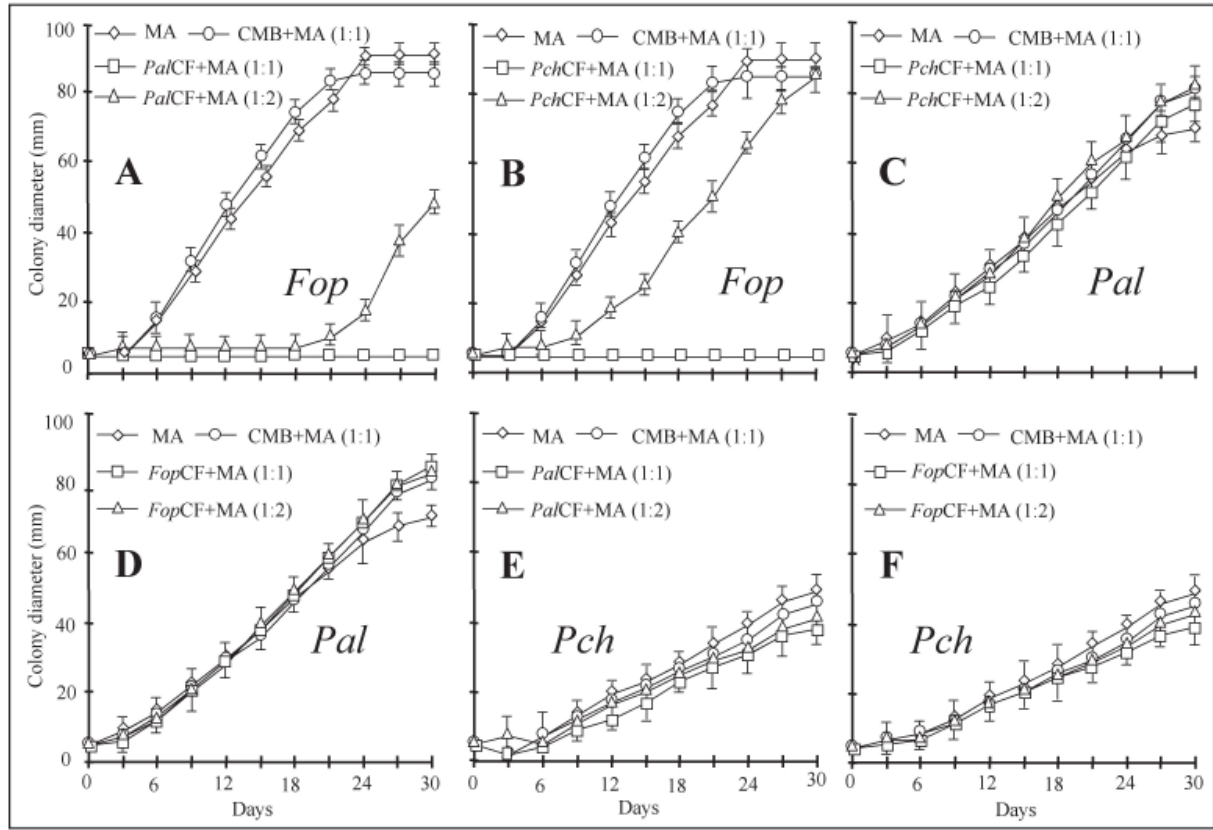
Fig. 2. Effect of culture filtrates (CFs) of each fungus, diluted 1:1 or 1:2 with malt-agar (MA), on growth rates of Fomitiporia punctata ( Fop ), Phaeoacremonium aleophilum ( Pal ) and Phaeomoniella chlamydospora ( Pch ): Fop with Pal CF (A) or Pch CF (B); Pal with Pch CF (C) or Fop CF (D); Pch with Pal CF (E) or Fop CF (F). Controls: malt agar (MA) and amended Czapek medium (CMB) diluted 1:1 with MA. Standard error bars are